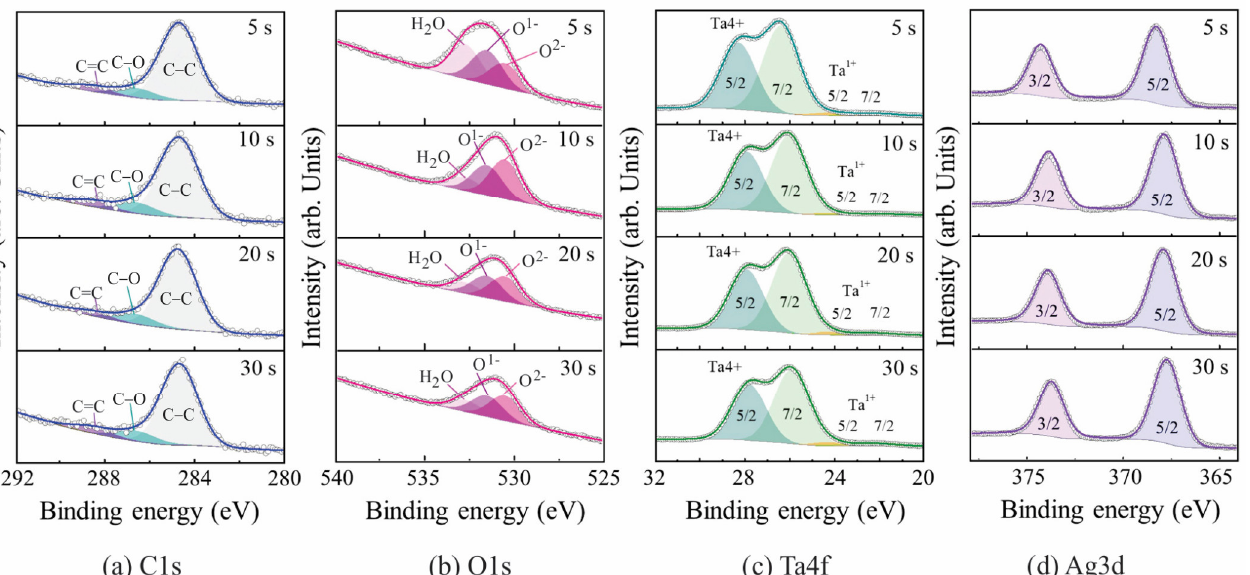
Figure 5. ( a ) XPS survey spectra and ( b ) composition percentage of the prepared Ag–Ta thin films.